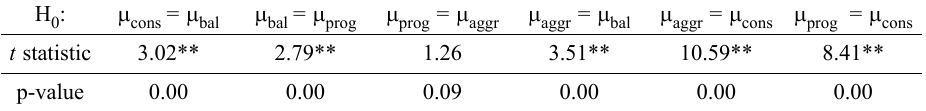
Table 15. Results of variance hypothesis testing across 4 fund categories (Estonian